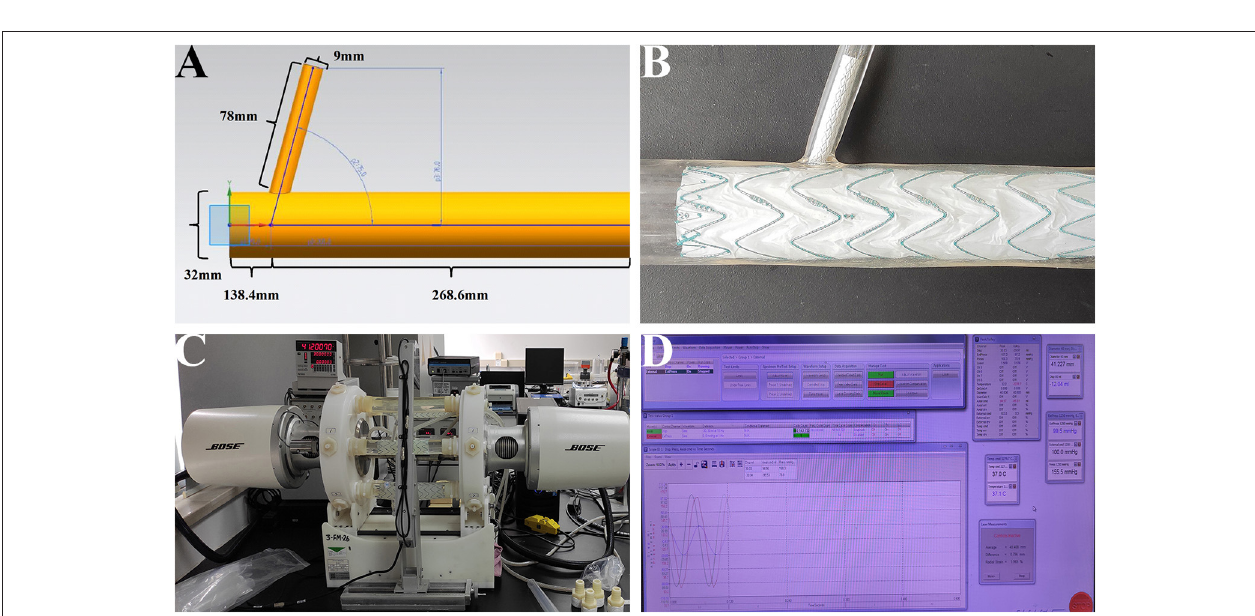
FIGURE 2 | In-vitro fatigue experiment on the MCPF stent grafts in silicone models. (A) The diagram of the silicone model. (B) The main and branch stent grafts were implanted into the silicone model. (C) After stent grafts implantation, all the silicone models were installed into the fatigue test machine to stimulate the relative movement of the aorta and branch artery with the aortic pulsation. (D) The parameters were automatically controlled by the computer, in which the temperature was 37 ◦ C, the average systolic/diastolic water pressure was 130/80mm Hg, and the beating rate was 1,000 bpm. MCPF, mini-cross prefenestration.